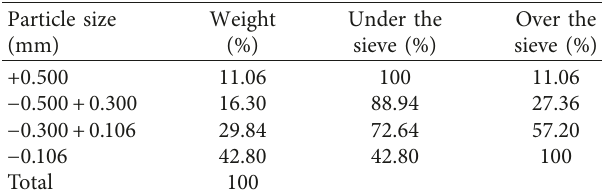
Table 7: Sample-C2 screen analysis values.